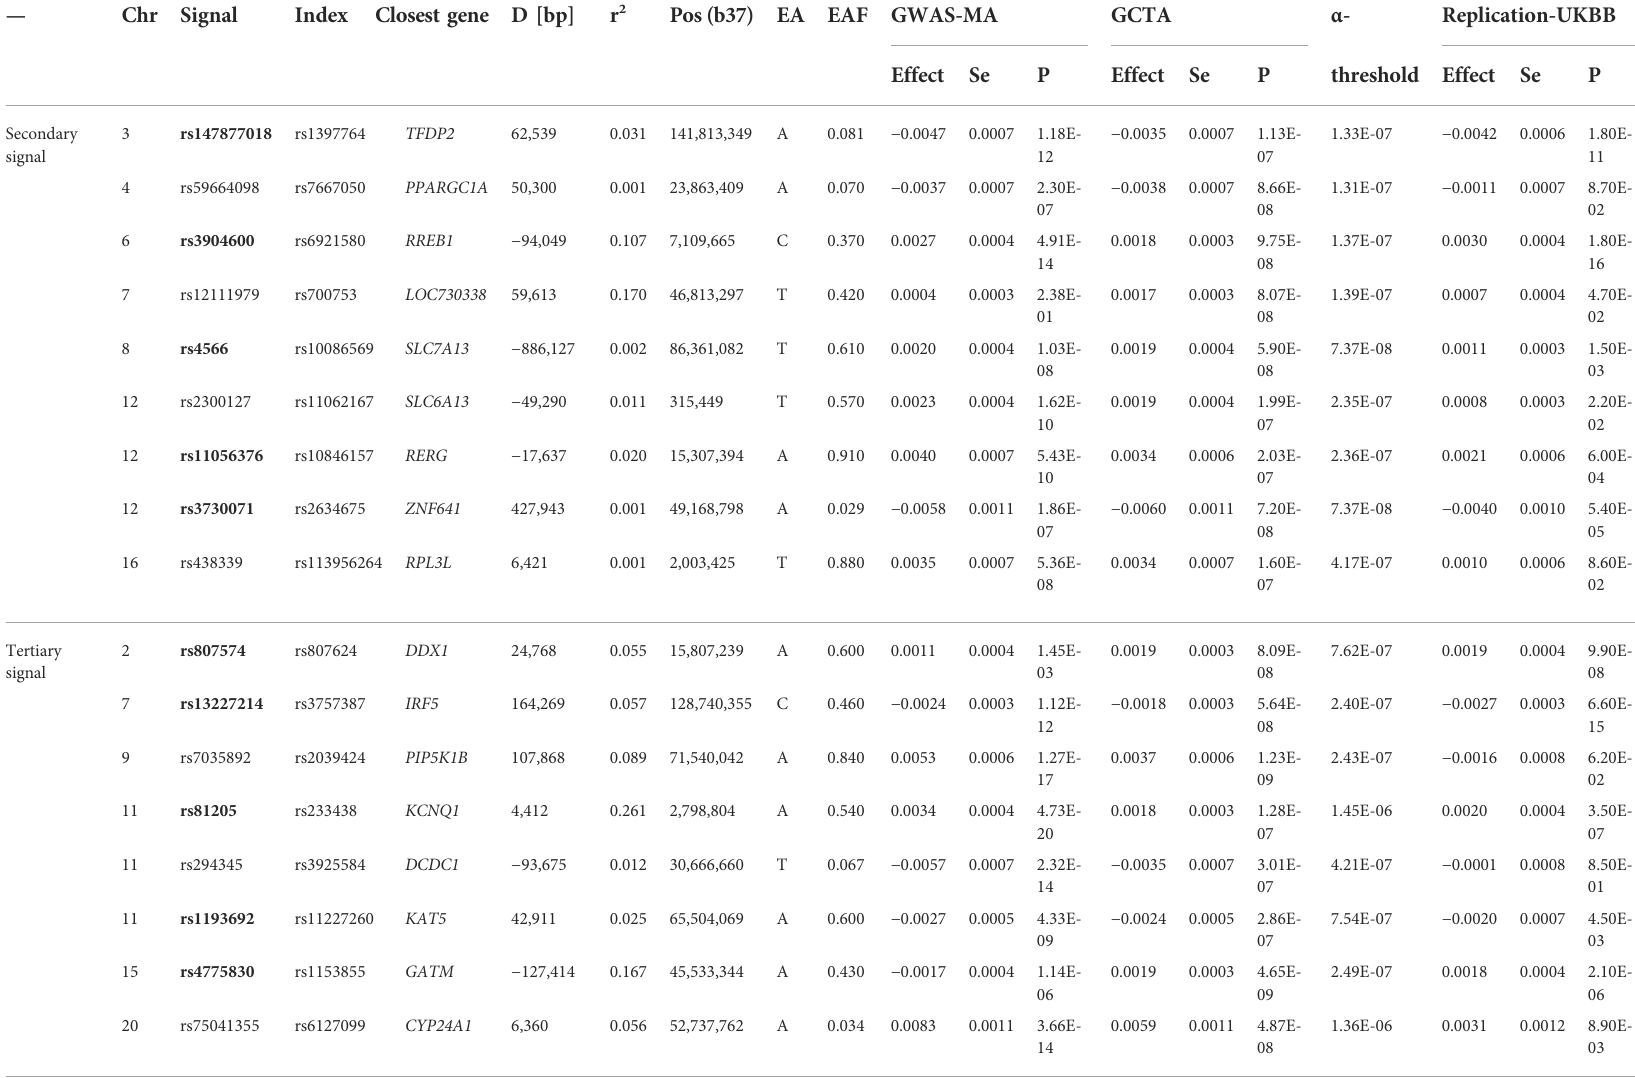
TABLE 1 Summary of novel independent eGFR-associated signals identi fi ed by quasi-adaptive method and replication results.